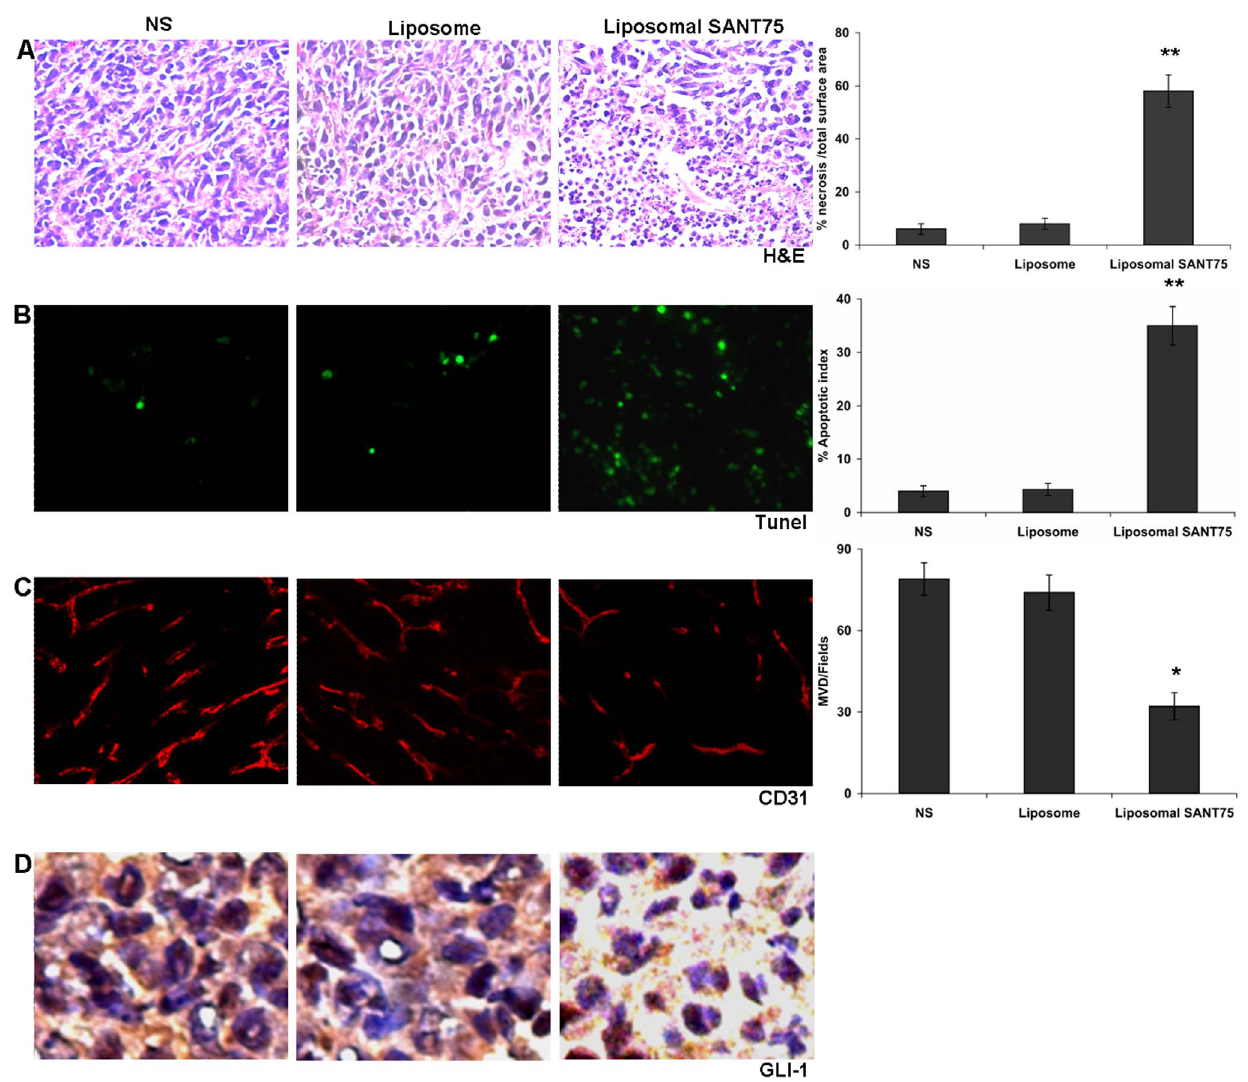
Figure 6. Histochemical analysis of tumor tissues in the normal saline group, free liposome group and liposomal SANT75 group. (A) H&E staining of the tumor tissues in each treatment group. Data represent the mean necrosis index 6 SDs of cancer cells. Columns, mean; bars, SD. **, P , 0.01, significantly different from the normal saline or liposome group. (B) TUNEL staining of the tumor tissues in each treatment group. Data represent the mean apoptotic index 6 SDs of cancer cells. Columns, mean; bars, SD. **, P , 0.01 significantly different from the normal saline or liposome group. (C) Inhibition of angiogenesis assayed by immunofluorescence staining with CD31. The number of vessels was counted as described in the methods. Columns, mean; bars, SD. *, P , 0.05 liposomal SANT75 group versus the normal saline or liposome group. (D) The Gli-1 expression by immunohistochemical detection in each treated tumor tissues.